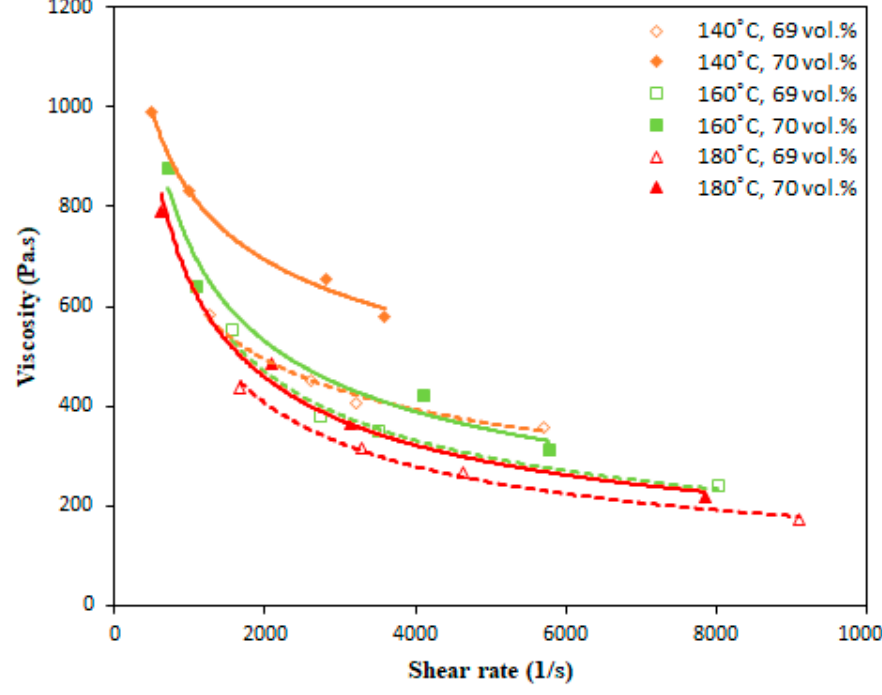
Figure 5. Relationship between the viscosity and shear rate of the SS 17-4PH feedstocks.